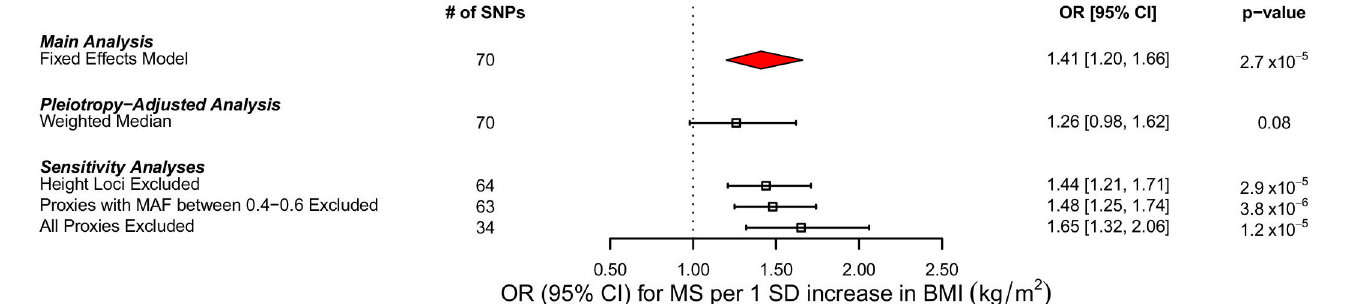
Fig 4. Forest plot of MR estimates. Forest plots of all main and sensitivity analyses. ORs for MS are reported for a 1 SD increase in BMI. Estimates were obtained using a fixed effects model. MAF refers to minor allele